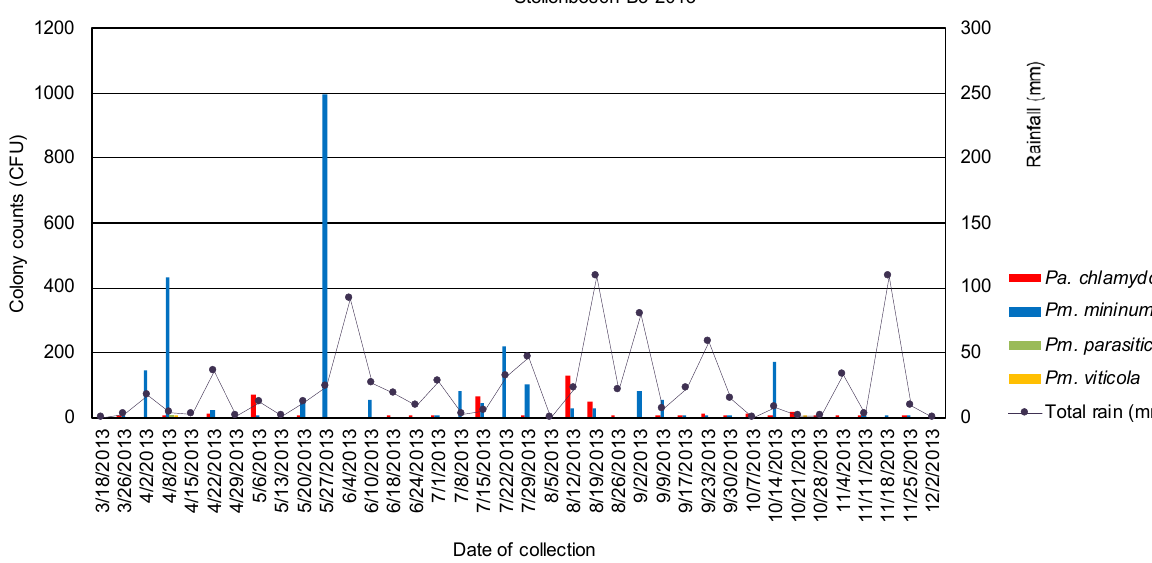
Figure 6. Phaeomoniella and Phaeoacremonium spp. cfu cultured from five vaseline coated microscope slides affixed to the cordons on each of five vines in vineyard Stellenbosch B3, Western Cape province in 2013. The slides were replaced weekly. Each bar represents the total number of cfu cultured on three Petri dishes. Not clear on the graph, detection dates for Pm. viticola are 08/04 and 21/10 and for Pm. para- siticum is 08/04.